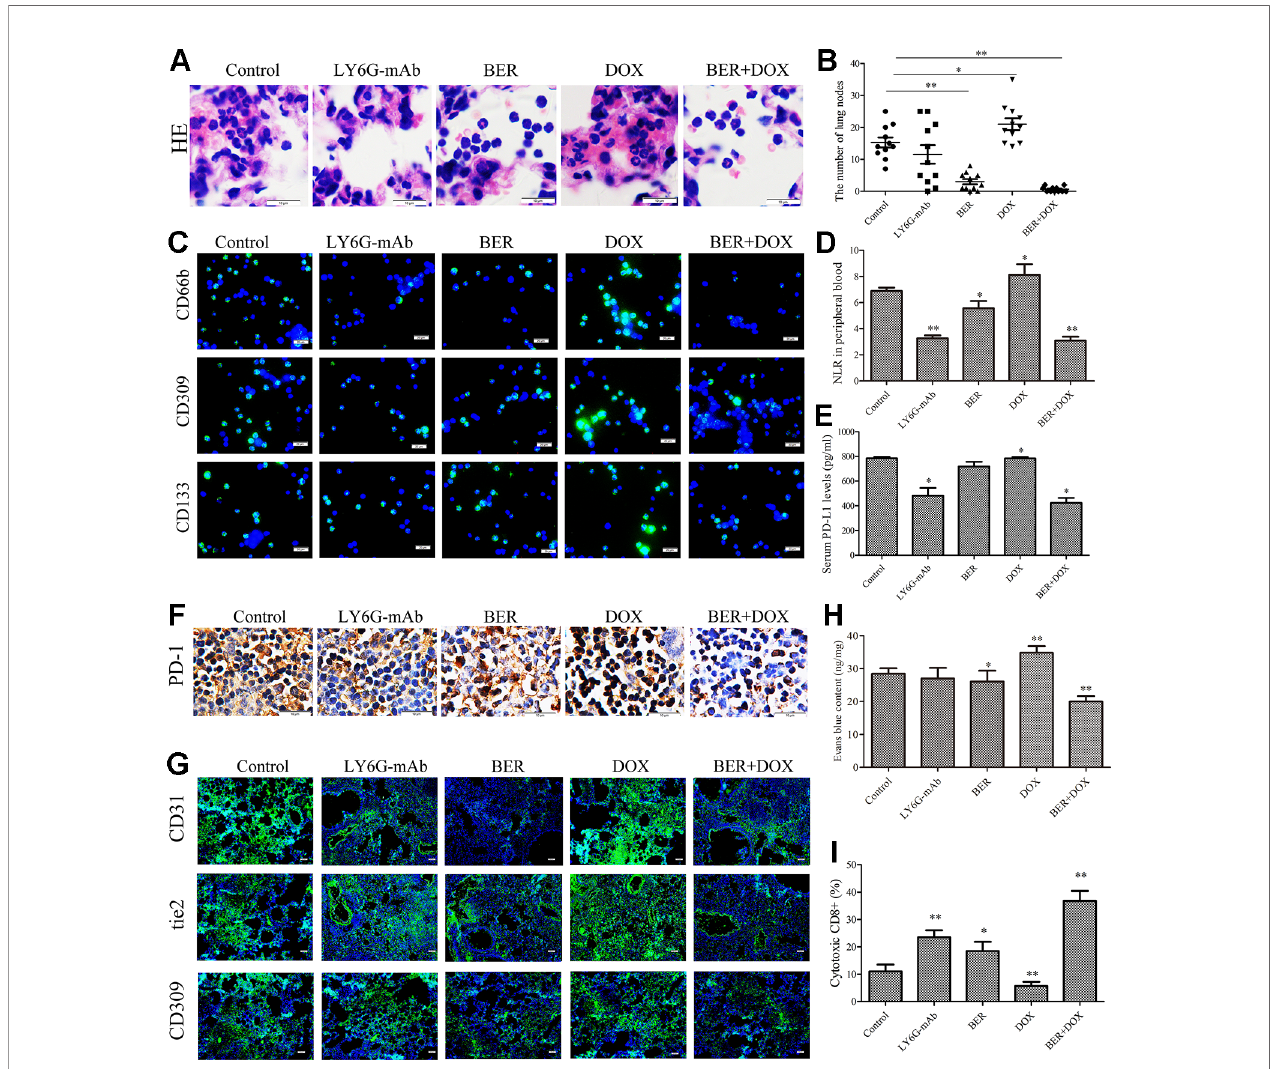
FIGURE 5 | Neutrophils affect urethane-induced lung carcinogenesis. (A) Alveolar neutrophils indicated by hemotoxylin and eosin (H&E) staining of lung tissue (n = 5, 100×). (B) The number of lung nodes (n = 10). (C) Alveolar neutrophil protein expression of CD66b, CD309, and CD133 indicated by immuno fl uorescence (n = 5, 40×). (D) NLR in peripheral blood (n = 5). (E) Serum PD-L1 levels (n = 5). (F) Spleen tissue PD-1 expression examined by immunohistochemical analysis (n = 5, 100×). (G) Lung tissue protein expression of CD31, tie-2, and CD309 indicated by immuno fl uorescence (n = 5, 40×). (H) Lung tissue permeability to Evans blue (n = 5). (I) Spleen cytotoxic CD8+ cell rate (n = 5). The data present mean ± SD, the experiments were repeated three times, and statistical signi fi cance was determined by a t-test. *P < 0.05, **P < 0.01 vs . control. DOX, doxorubicin; BER,